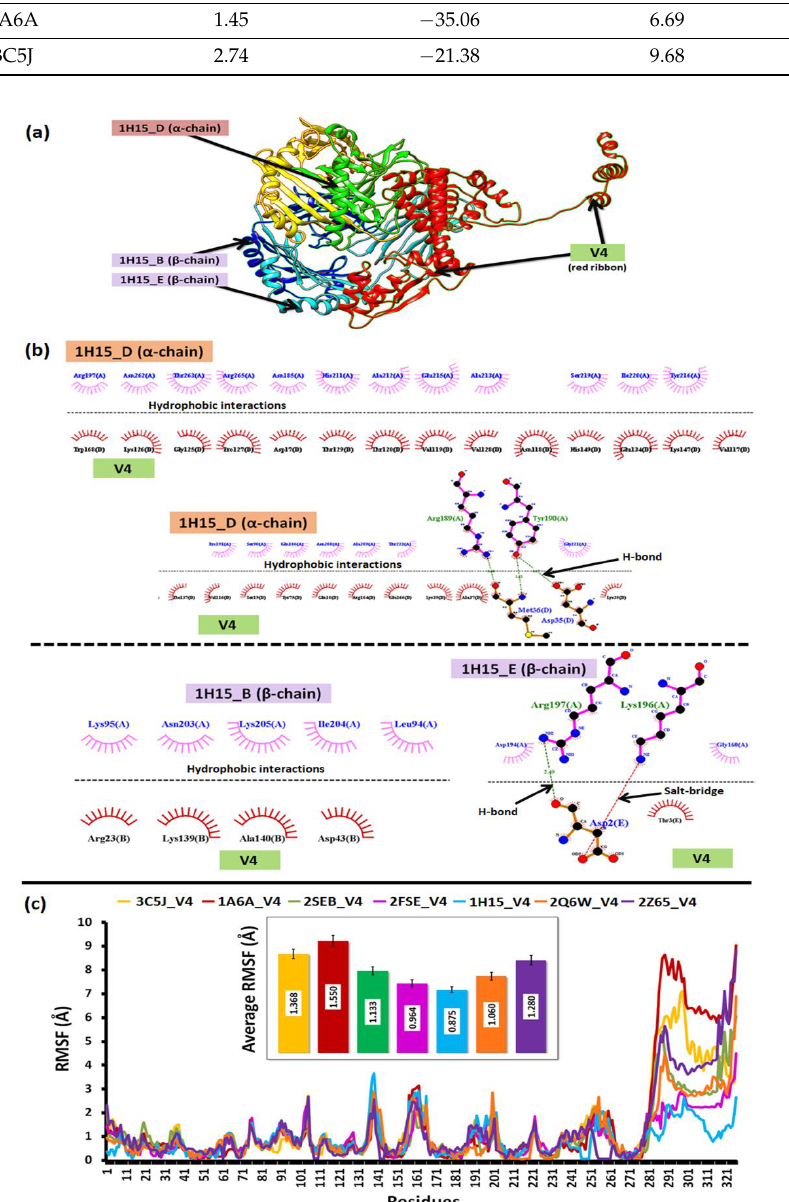
Figure 5. The docking and dynamics profile of V4 shows ( a ) V4 complex with 1H14, ( b ) inter-molecular interactions between the V4-1H14 complex, and ( c ) the relative structural dynamics profile of the V4 complex with all the immune targets.